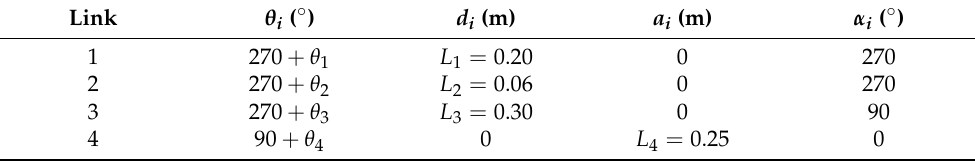
Figure 6. Detail of the implementation of the arm: ( a ) partial view of the structure that holds motor M 1 , with motors M 2 and M 3 attached; ( b ) lateral view of the robot shoulder, with M 1 in the background and M 2 and M 3 in the foreground; and ( c ) lateral view of the robot elbow, with M 4 . Table 3. Denavit–Hartenberg parameters for each link of the left articulated arm of the robot.